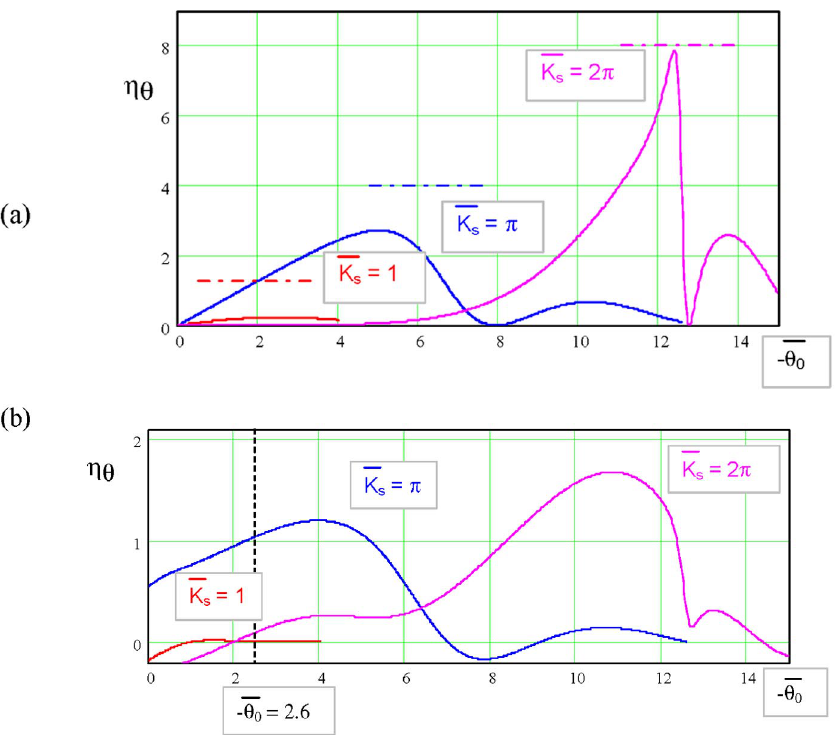
FIG. 11. (Color) Normalized extraction efficiency 7 conventional FEL lines indicate the upper limit value of 7